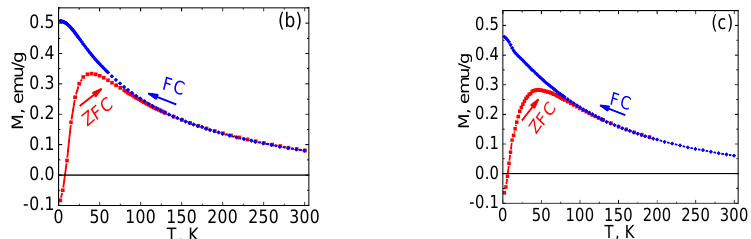
Figure 10. Zero-field-cooled (ZFC) (red line) and field-cooled (FC) (blue line) magnetization curves of Ni NPs@PPP under the applied magnetic field of 100 Oe: H200 ( a ), H280 ( b ), and I280 ( c ).